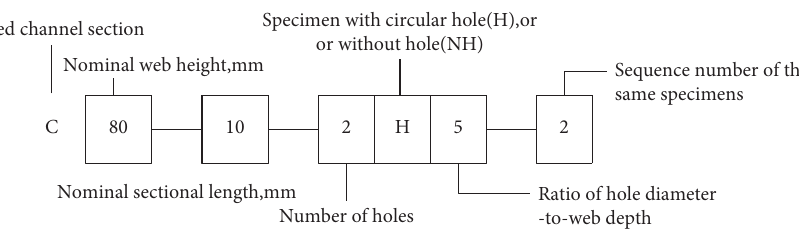
Figure 3: Label rule of the